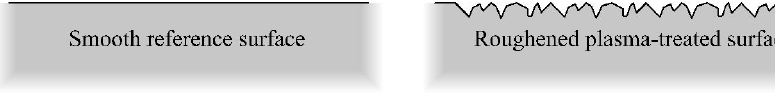
Figure 1. Principle of physical surfaces treatment (from own resources).